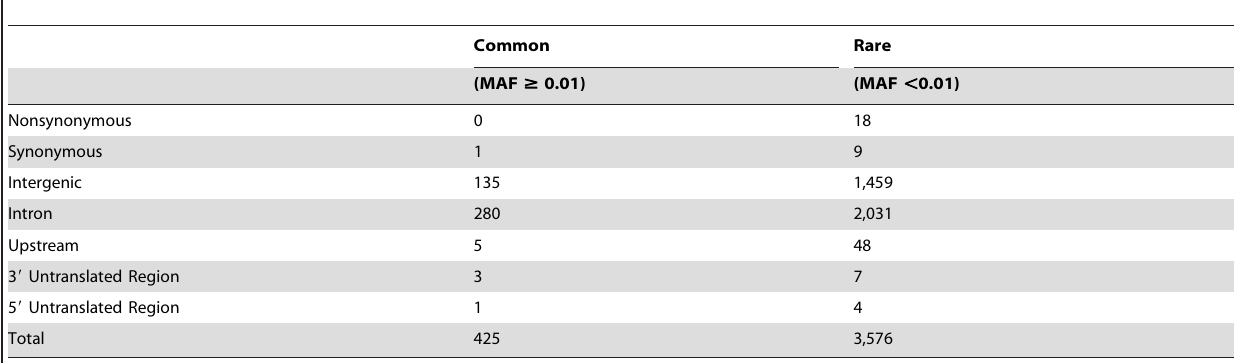
Table 2. Characteristics of variants in the NINJ2 targeted